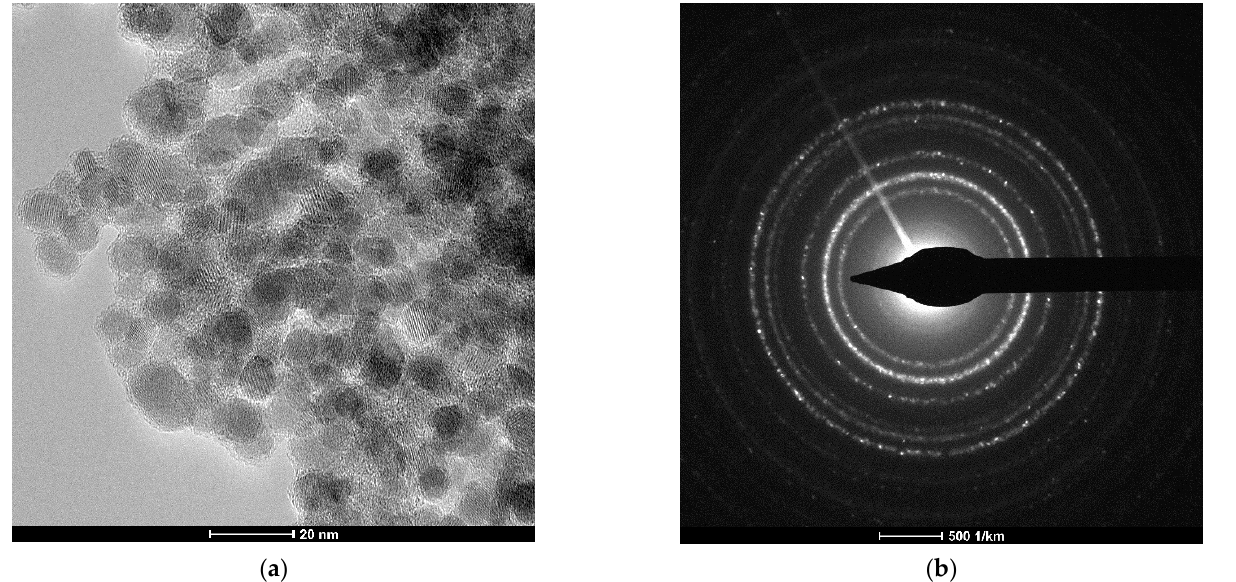
Figure 2. ( a ) TEM and ( b ) SAED images of magnetite nanoparticles with PABA shell. The presence of the organic layer coating the magnetic nanoparticles Fe 3 O 4 -PABA is proved both by the elemental composition (Fe, O, C and N) provided by Energy dispersive X-ray spectroscopy (EDX) (Figure S2 in the Supplementary Materials) and by the characteristic absorption bands in the FT-IR spectrum (Figure 3). The most representative bands are the stretching of the free –NH 3+ group at 3412 cm − 1 , asymmetric stretching vibrations of carboxylate groups at 1591 cm − 1 , and the O-H bending band from the carboxylic group at 1439 cm − 1 . The characteristic band assigned to the Fe-O stretching can be observed at 540 cm − 1 .